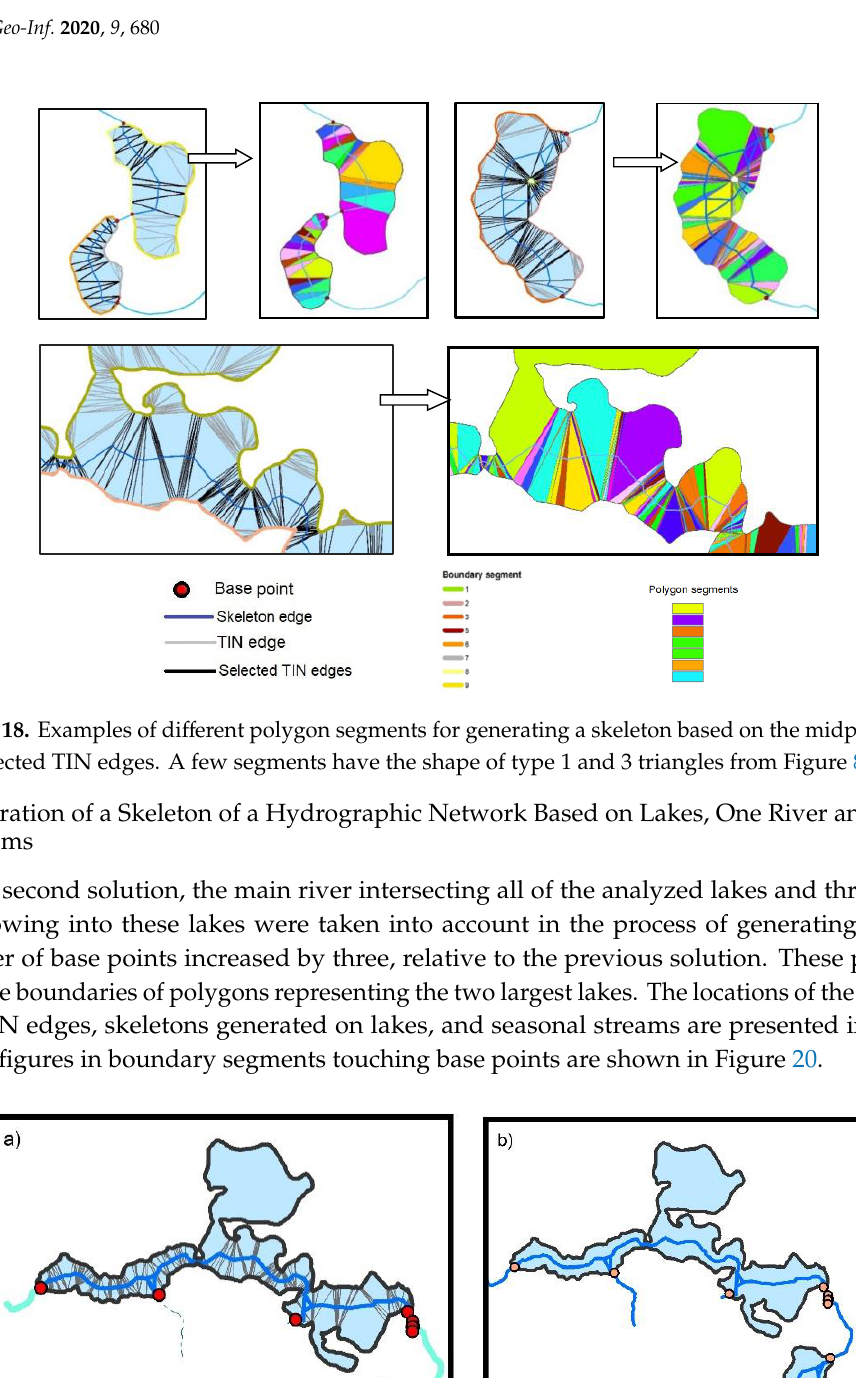
Figure 19. Skeleton of the hydrographic network generated based on 11 base points in four lakes, one river intersecting all lakes, and three seasonal streams flowing into the analyzed lakes: ( a ) generation process; ( b ) results.